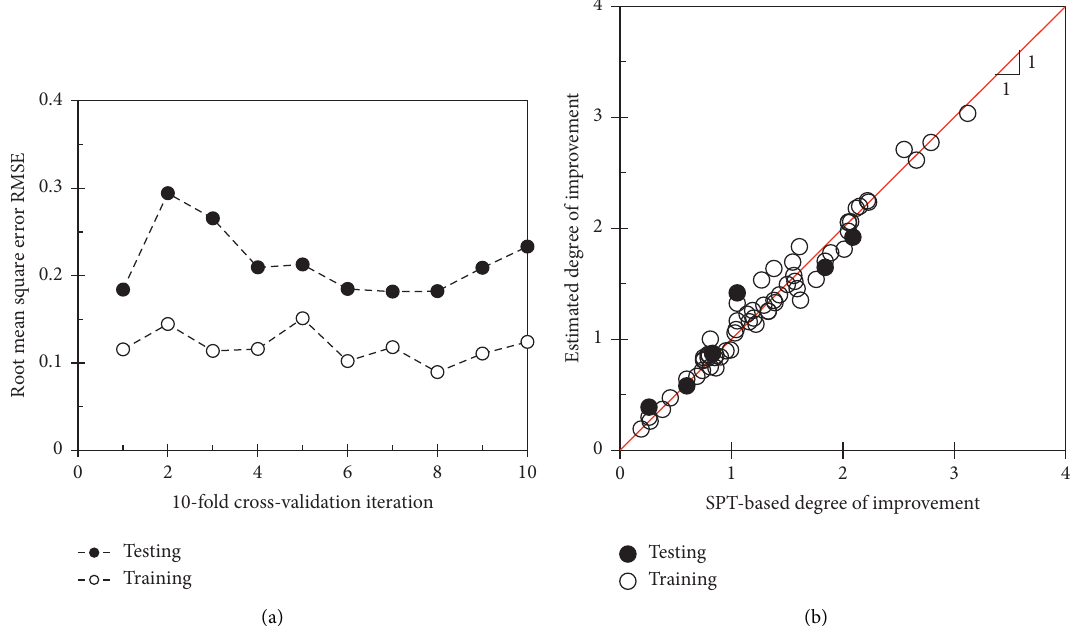
Figure 9: Cross-validation plots for observed and predicted degree of ground improvement (DI) using ANN: (a) Root mean square error RMSE plot for training and testing subsets under 10-fold cross-validation, and (b) cross-validation plot for training and testing of the eighth fold. CV utilizing training subset resulted in a mean absolute error MAE � 0.08, coefficient of determination r 2 � 0.97, and root mean square Table 4: Summary statistics of total, training, and testing subsets used for ANN modeling. Model